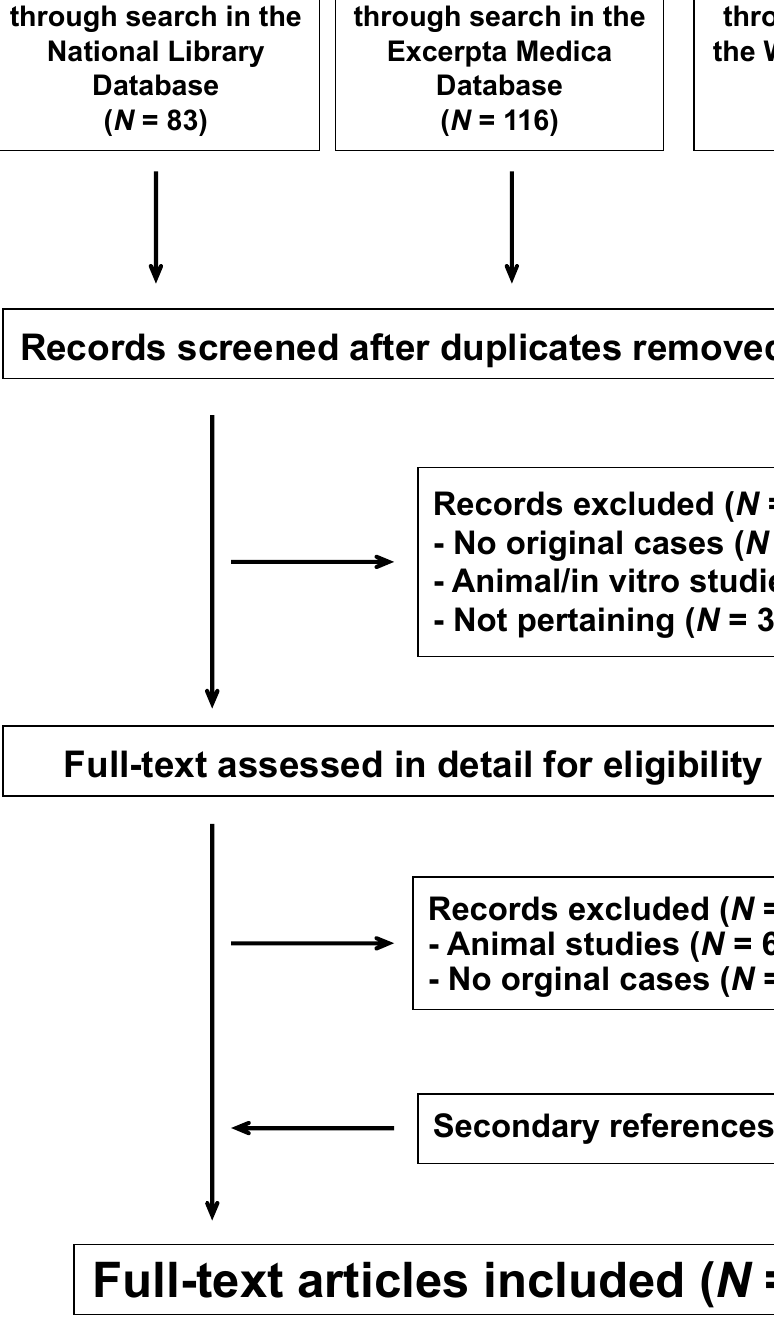
Figure 3. Dietary chloride deficiency syndrome. Flowchart of the literature search process.